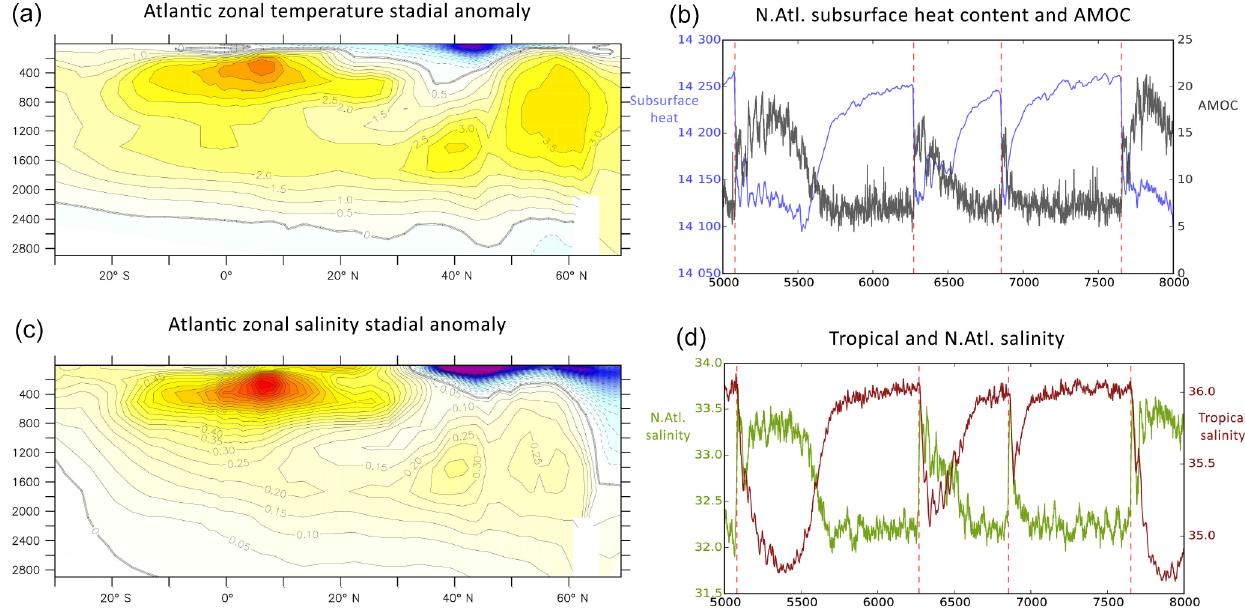
Figure 5. Thermohaline oscillations in the unhosed simulation. (a, c) Atlantic zonally averaged temperature and salinity anomalies between weak AMOC state (years 7501–7600) and strong AMOC state (years 7901–8000). Units in ◦ C and PSU, respectively. (b) Subsurface (500– 2500m) heat content in the North Atlantic >45 ◦ N in zettajoules (blue) and AMOC transport in sverdrups (black). (d) Sea surface salinity in the North Atlantic (>45 ◦ N) (green) and tropical Atlantic (0:10 ◦ N, 70:30 ◦ W) (red), in PSU. Red vertical dashed lines indicate onset of deep convection in the North